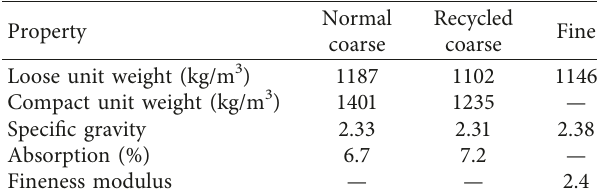
Table 1: Aggregate properties.